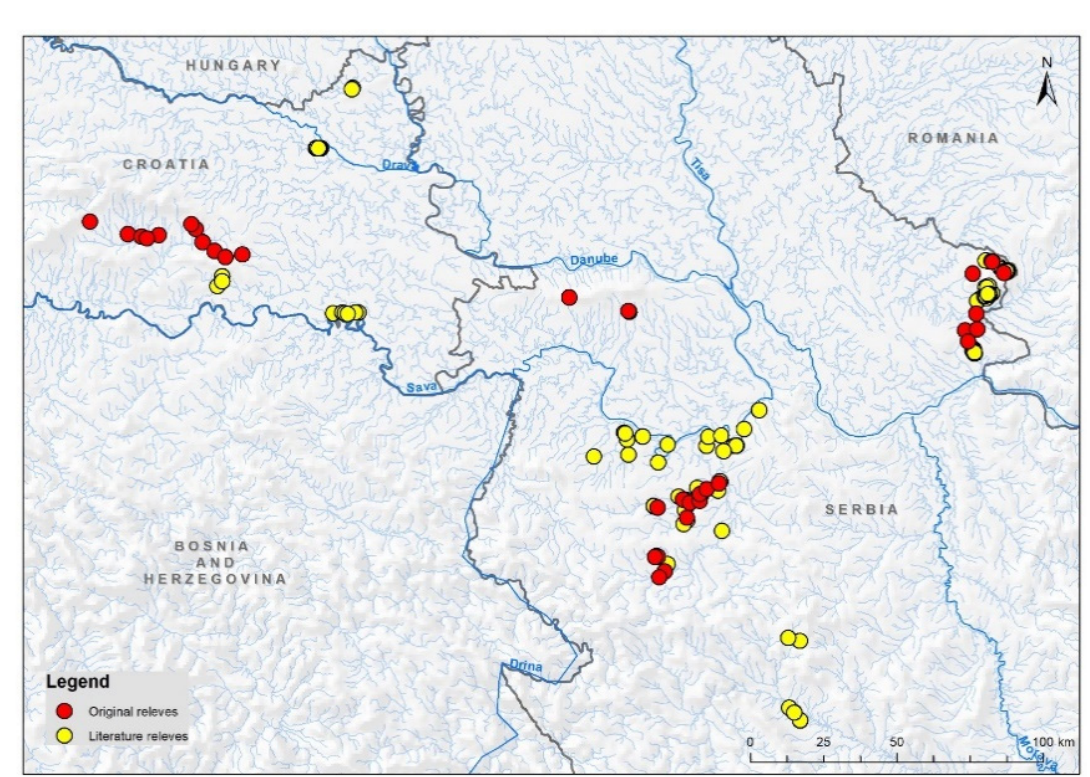
Figure A1. The geographical position of original relev é s from fieldwork sampling and relev é s collected from the Figure A1. The g eographical position of original relevés from fieldwork sampling and relevés collected from the litera- ture.